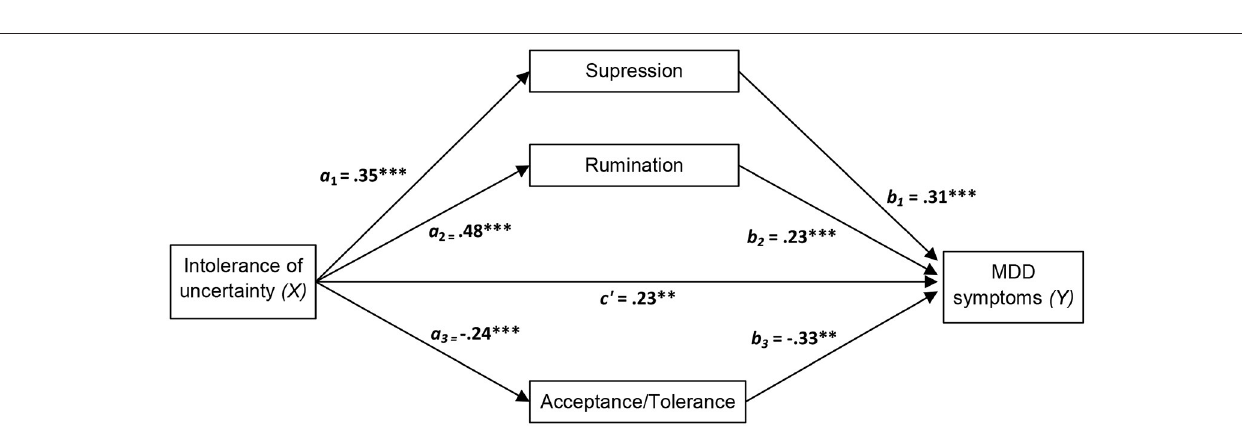
FIGURE 3 | Diagram of the parallel multiple mediator model for the direct and indirect effects of intolerance of uncertainty on major depressive disorder (MDD) symptoms via emotion regulation strategies (acceptance/tolerance, suppression, and rumination). Fully standardized regression coefficients are shown. See Table 5 for indirect and total effect coefficients. a , effect of X on a mediator; b , effect of the mediator on Y ; c ′ , direct effect of X on Y . ** p < 0.01; *** p <